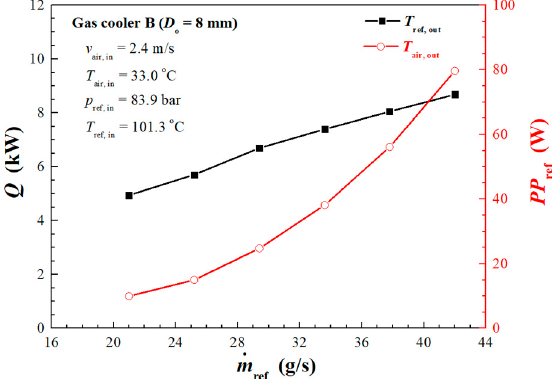
Figure 13. Influence of refrigerant mass flow rate on heat-transfer rate and sCO 2 pumping power for gas cooler B.